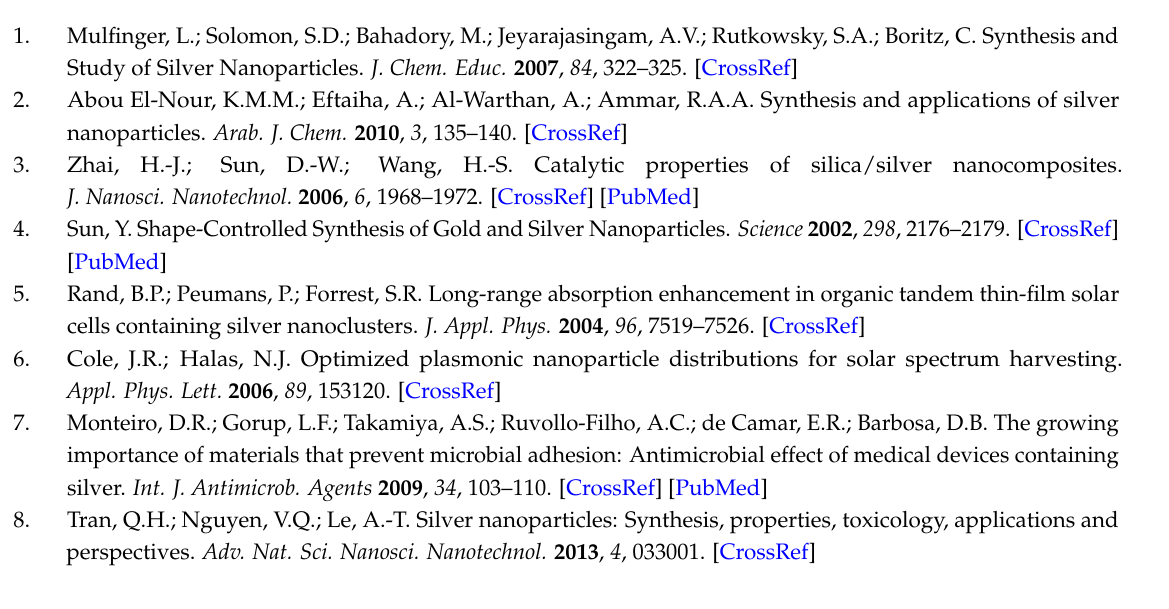
Figure S3: FT-IR spectra graph of various types of purified mesquite gums and Arabic gum, Table S1: Data table with the Newtonian model rheological parameters of the different samples of lyophilized mesquite gum and Arabic, Table S2: Data table with the TGA parameters of the different samples of lyophilized mesquite gum and